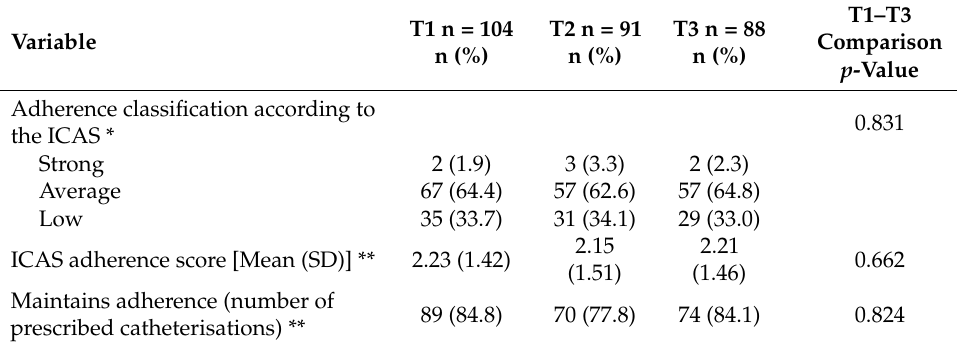
Table 7. Evolution of adherence to and continued use of IBC. ICAS—Interpersonal Communication Assessment